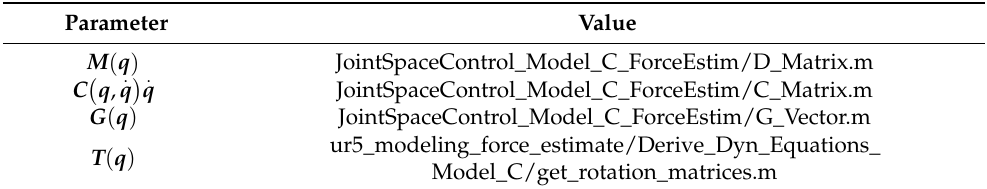
. (cid:0) (cid:1) . q , q q , G ( q ) , and T ( q ) under